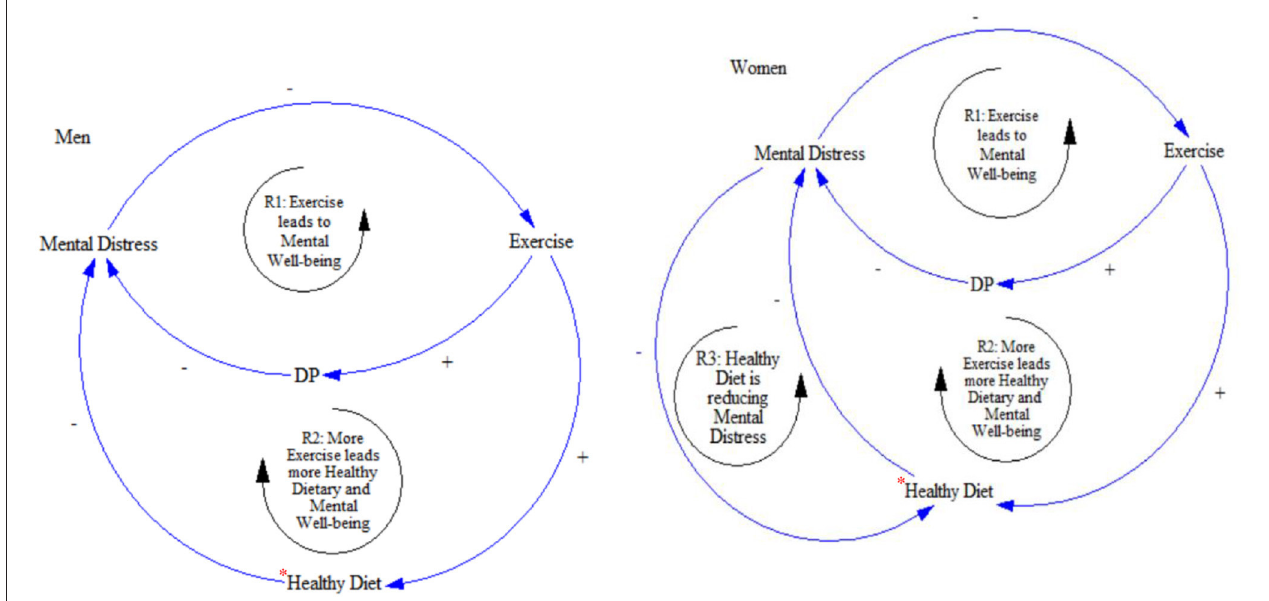
FIGURE 4 | The revised CLD diagrams of the SD model based on gender. *Healthy diet is